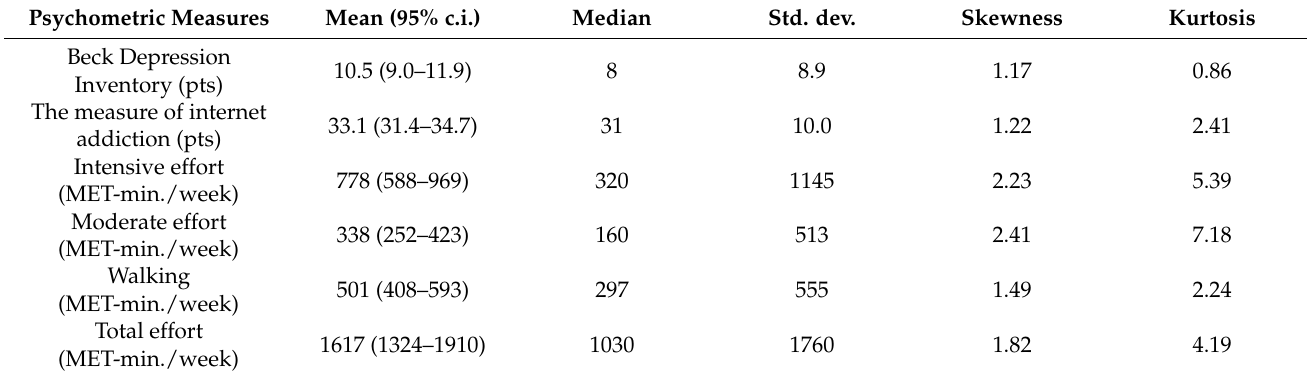
Table 1. Summary statement on the distribution of psychometric measures.